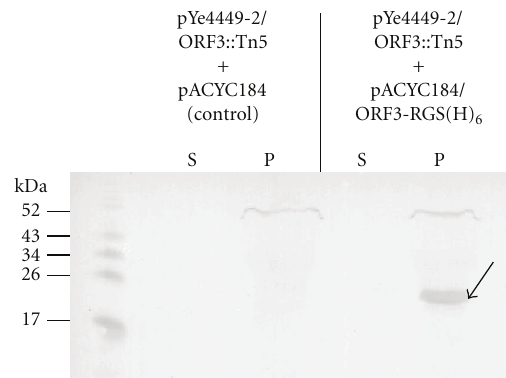
Figure 4: Detection of epitope-tagged ORF3 expressed at 4 ◦ C. A transposon mutant derivative of isolate 07-04449 carrying plasmid pYe4449-2/ORF3::Tn5 was transformed with plasmid pACYC184/ORF3-RGS(H) 6 and pACYC184, respectively, and cul- tured over night at 4 ◦ C in LB broth. Bacterial pellet fractions “P” and TCA-precipitated supernatant fractions “S” were subjected to denaturing SDS-PAGE. Subsequently, the gel was Western-blotted followed by chromogenic detection using a monoclonal antibody directed against the RGS(H) 4 epitope. The arrow indicates the ORF3-RGS(H) 6